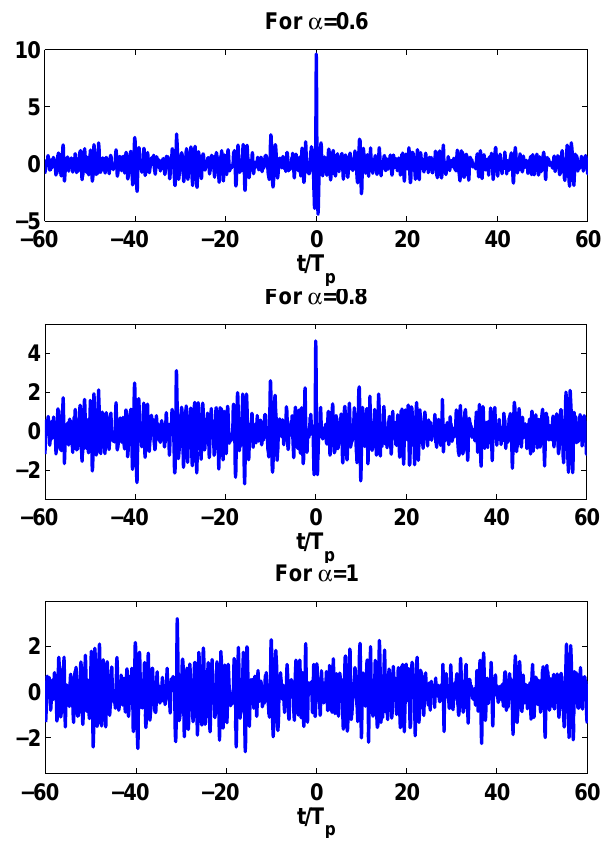
Fig. 3. Jonswap signal with significant wave height of 3.4m and random phases in α( − π,π ] in which α = 0 . 6, α = 0 . 8, and α =